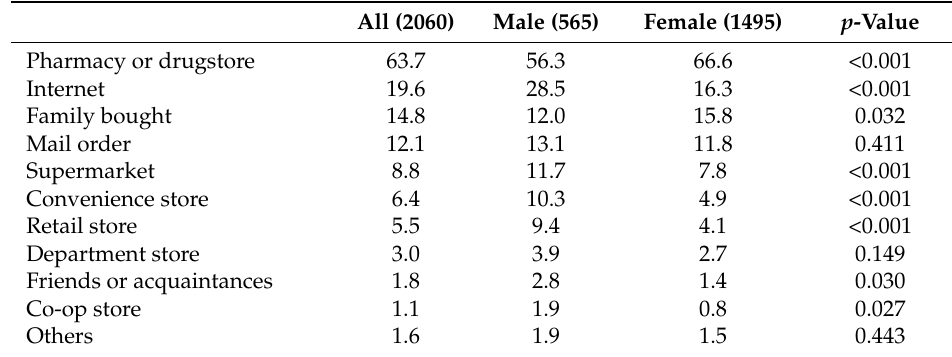
Table 4. How do you obtain dietary supplements?